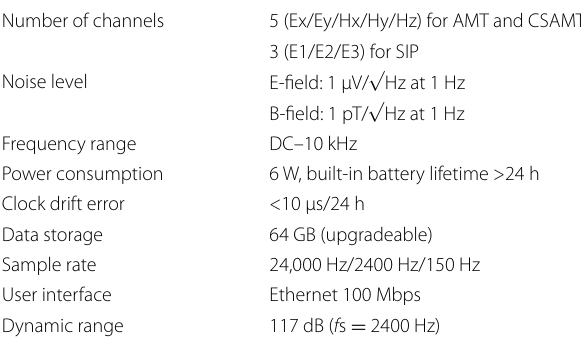
Table 1 Specifications of the electromagnetic